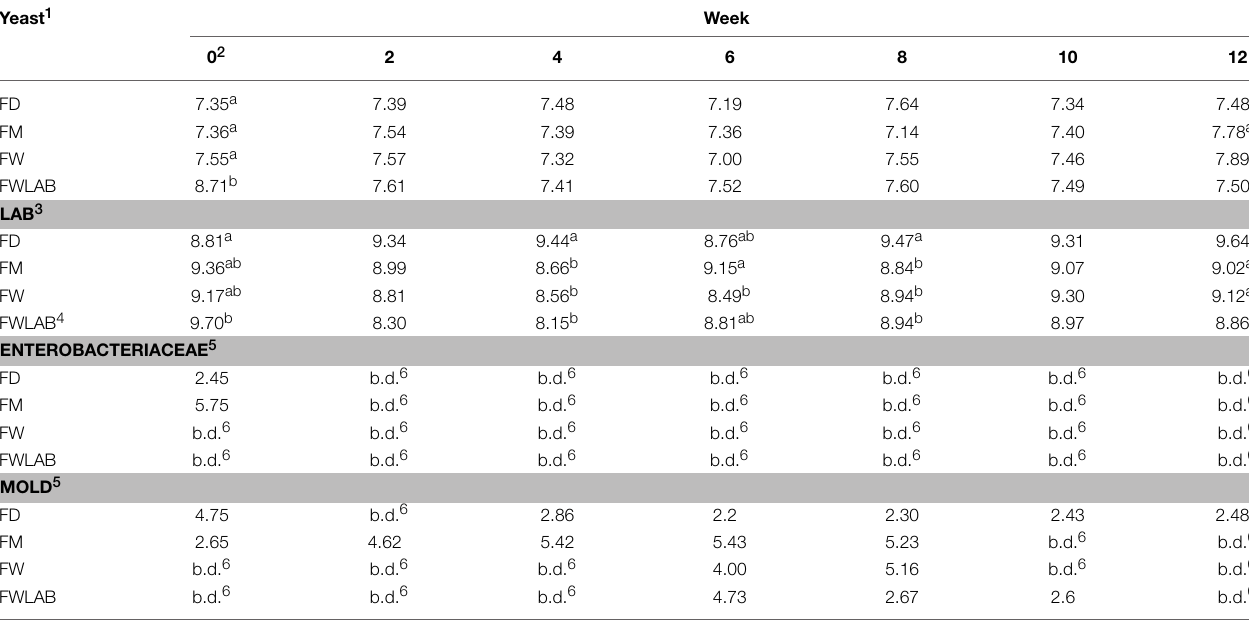
TABLE 4 | Microbial quantification (Log 10 cfu g − 1 grain) of Yeast, Lactic acid bacteria (LAB), Enterobacteriaceae and Mold in Fermented dried crimped barley (FD); fermented moist crimped barley (FM); fermented moist crimped barley storage-inoculated with Wickerhamomyces anomalus (FW); fermented moist crimped barley storage-inoculated with Wickerhamomyces anomalus and LAB starter culture; additional LAB starter culture inoculated at the beginning of fermentation